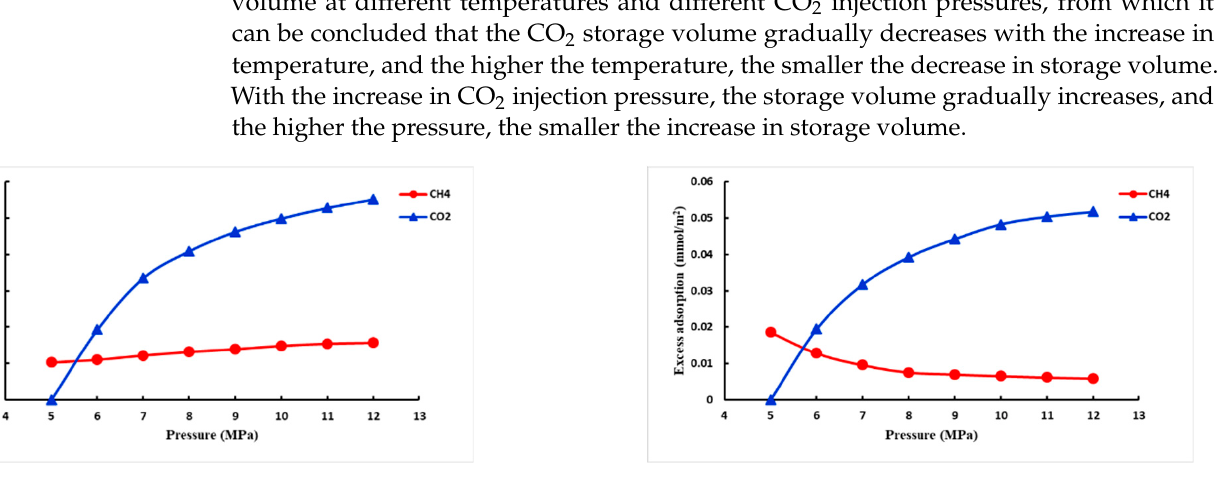
8 of 11 Figure 8. Pore size distribution curve of montmorillonite samples (a obtained by BJH method, b obtained by NLDFT method) [18]. Reproduced with permission from Xiong J., Doctoral thesis of